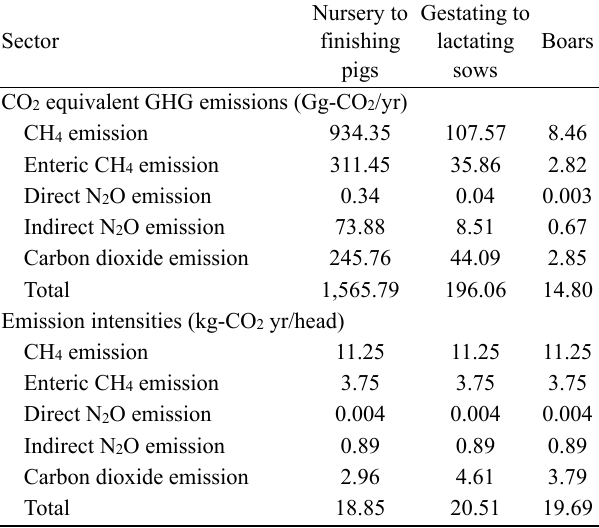
Table 4. Average CO 2 equivalent GHG emissions (Gg-CO 2 /yr) and emission intensities (kg-CO 2 /yr/head) in pigs from 2005 to Nursery to